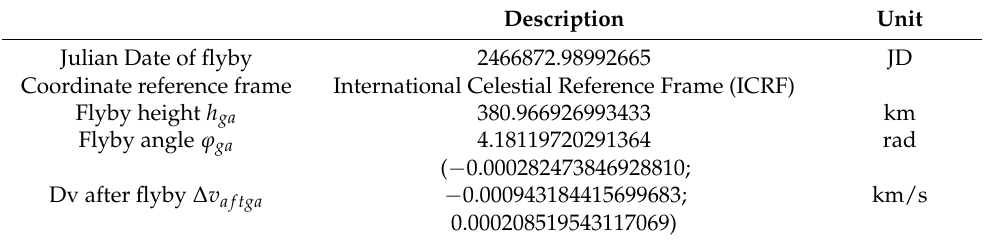
Table 9. Asteroid 2012 TF79’s deterministic information.